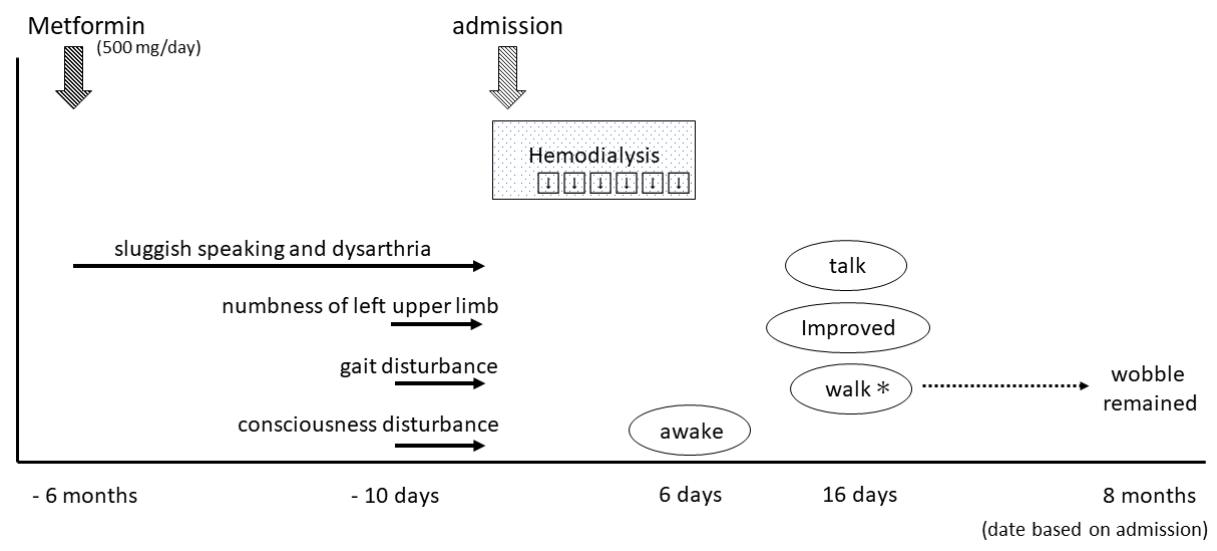
Figure 2. �he patient started metformin treatment at si�� months prior to admission.�he patient started metformin treatment at si�� months prior to admission. Since that time, he developed gradual symptoms of sluggish speaking and dysarthria, while numbness of his left upper limb, gait disturbance, and consciousness